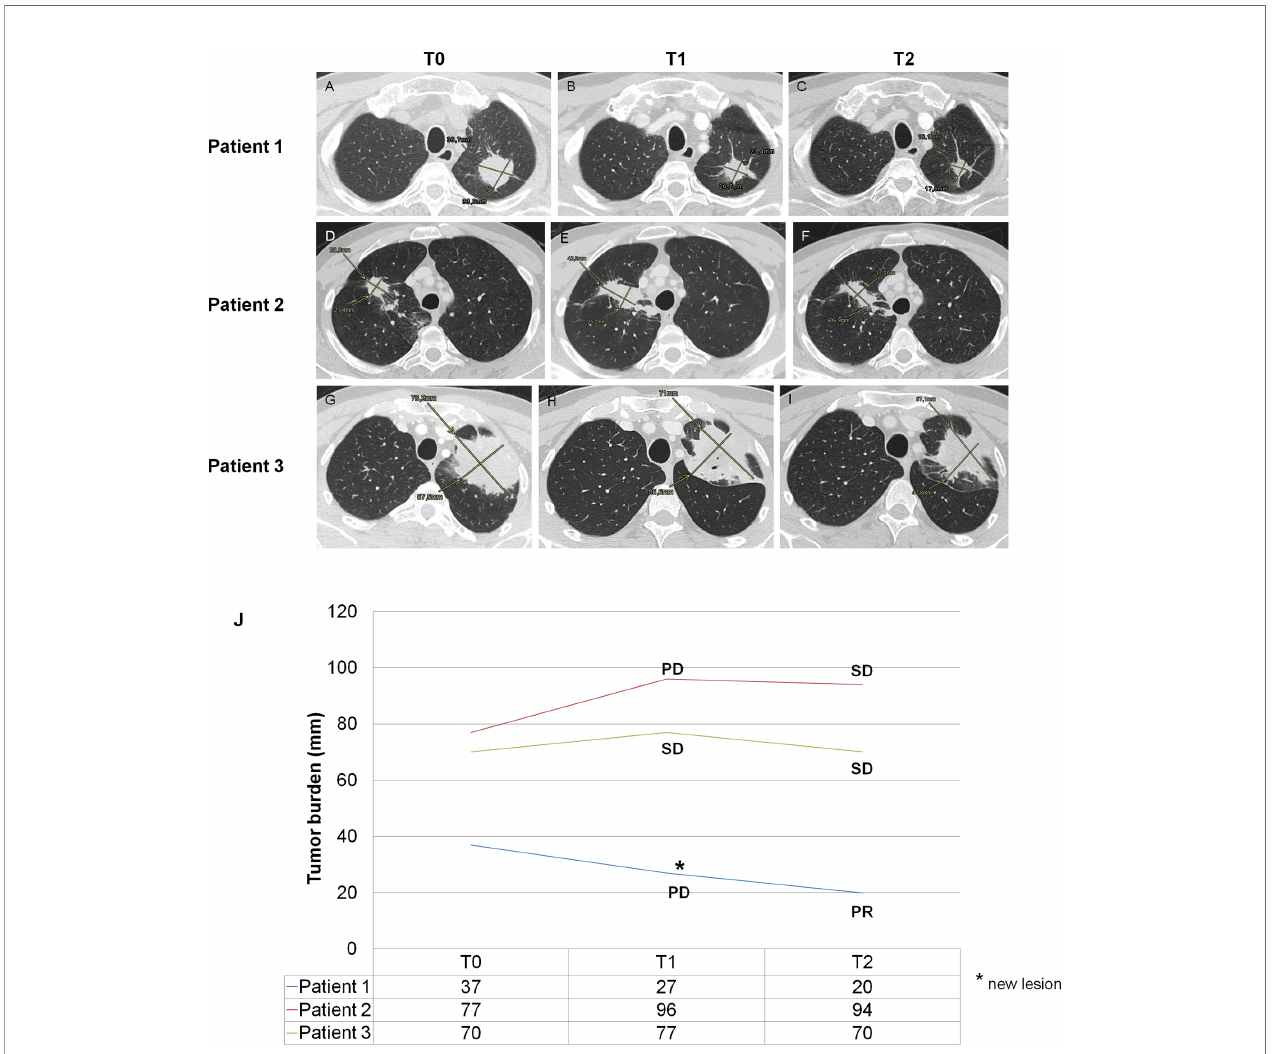
FIGURE 1 | Clinical imaging. For clinical case 1, the CT scan shows a progressive size reduction of primary tumor localized in the left superior lobe (B, C) in comparison with baseline (A) . For clinical case 2, the CT scan (E) shows dimensional increase of primary tumor localized in the right superior lobe in comparison with baseline (D) . This increase could be explained as a pseudo-progression because of the reduction of the same lesion in the subsequent CT scan (F) . For clinical case 3, the CT scan (H, I) shows a size reduction of primary tumor localized in the left superior lobe in comparison with baseline (G) ; in H, the signs of a partial cavitation (arrow) for necrosis can also be observed. (J) The graph shows the changes in the sum of the diameters of target lesions at T0, T1 and T2. The classi fi cation of response according to the RECIST criteria is associated with each time point. mm, millimeters; PD, progressive disease; SD, stable disease; PR, partial